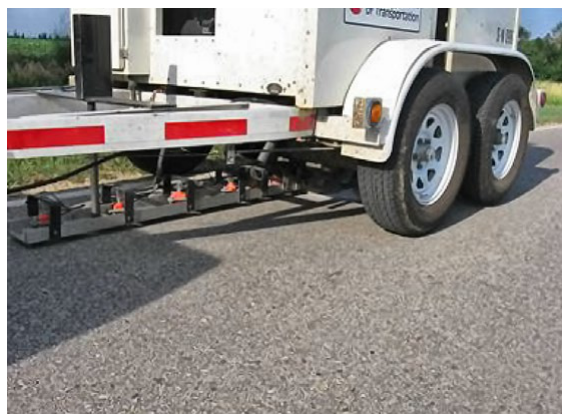
Fig. 1. Close-up of truck-mounted falling weight deflectometer (FWD) used in non-destructive testing (NDT) of